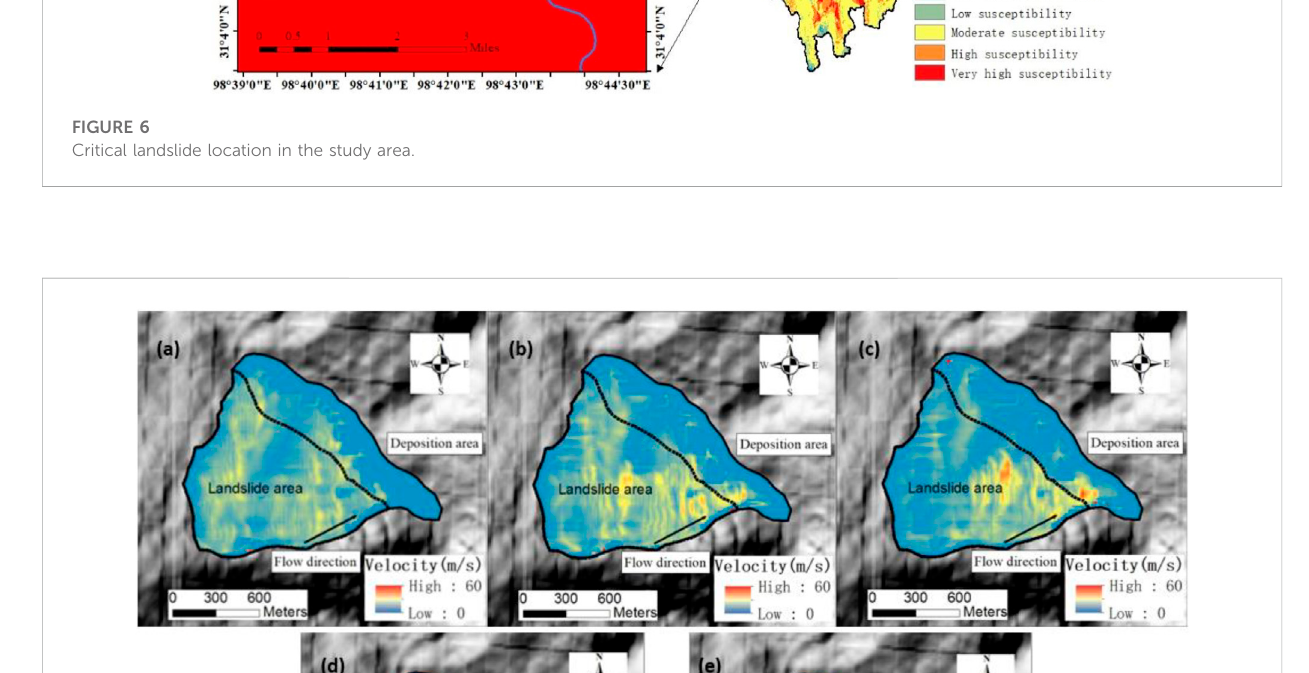
From t = 20 – 40 s, the landslide movement is uniform with an average velocity of 15 m/s (Figure 7B). The mass at the front edge of the landslide reaches the Jinsha River at t = 40 s. The main acceleration stage refers to the period from t = 40 – 80 s, and the peak value of the velocity reaches approximately 59 m/s (Figure 7C). During this period, the rock mass is divided into